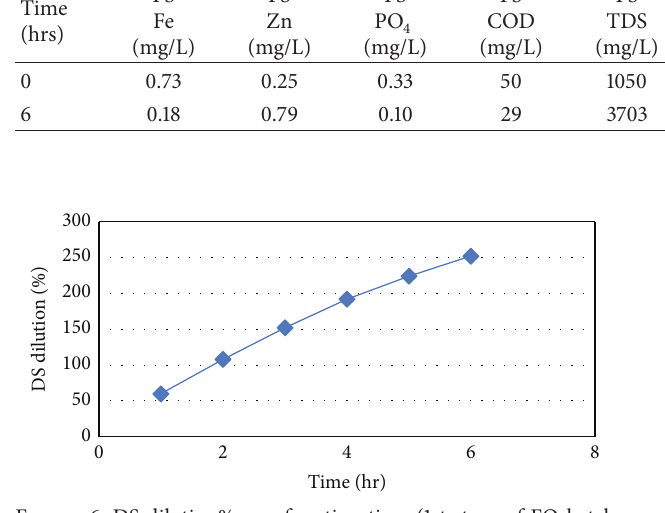
Figure 6: DS dilution% as a function time (1st stage of FO-batch process).